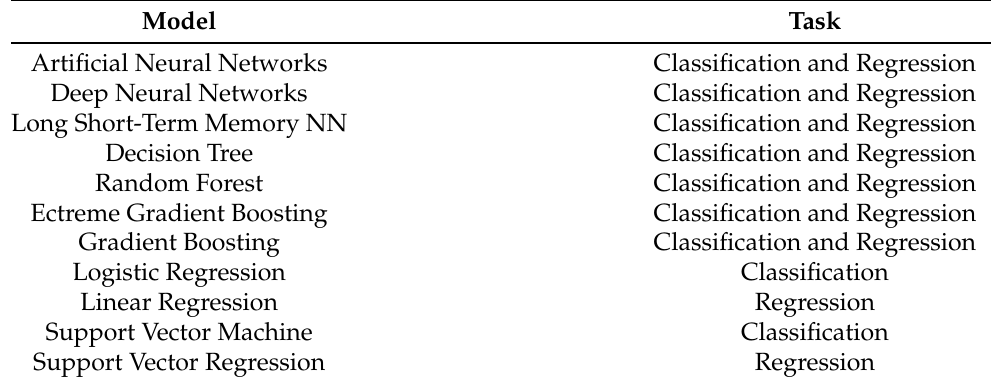
Table 1. Frequenly used machine learning Models in student performance prediction and their